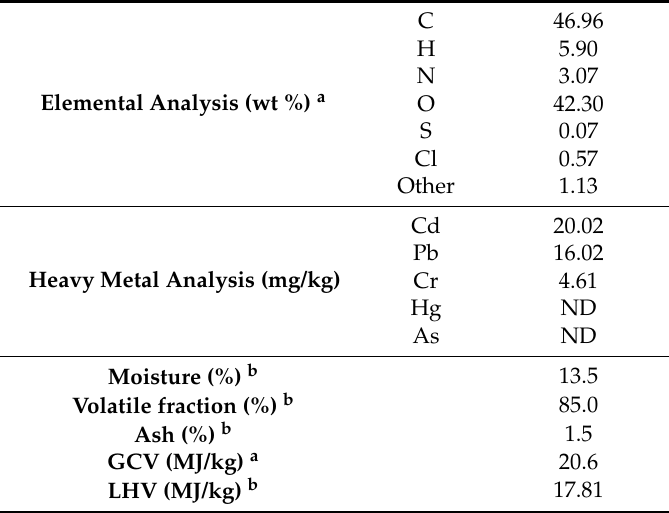
Table 1. Properties of waste wood (raw).